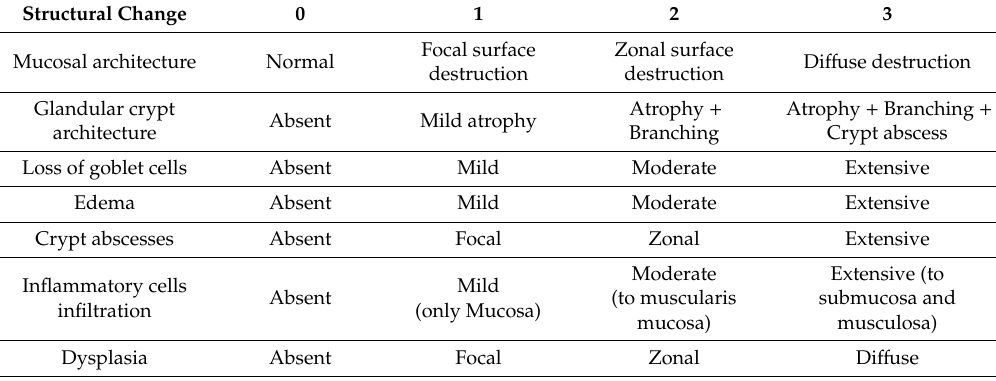
Table 3. Histological Changes. A Scale Adapted and Modified from Hussein et al. is Used to Calculate the Scores, Where Seven Listed Parameters were Evaluated. Each Parameter has Four Scores from 0 (normal) to 3 (altered) Based on the Degree of Structural Changes